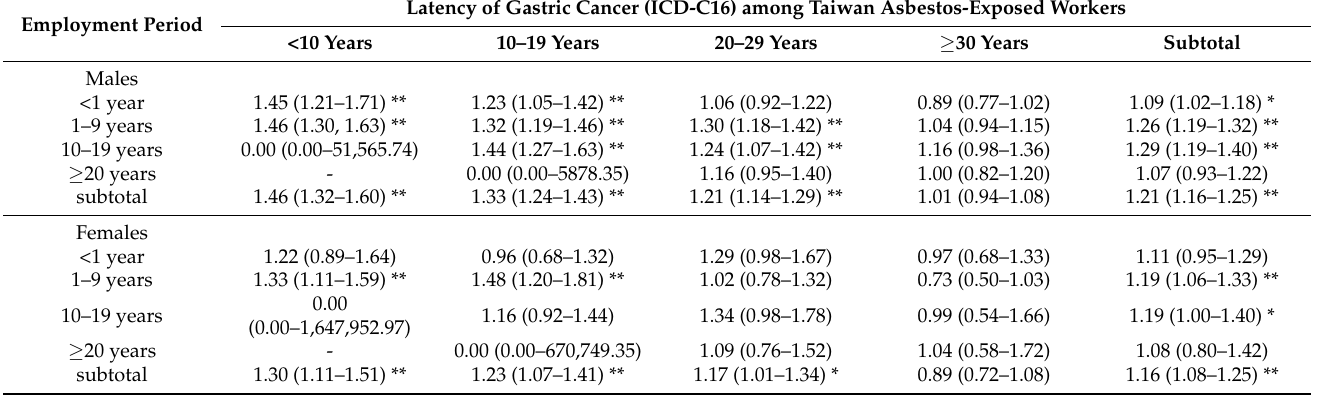
Table 3. Standardized incidence ratio (SIR) of gastric cancer among Taiwan asbestos-exposed workers, stratified by the employment period registered on labor insurance, using controlled generation of workers as